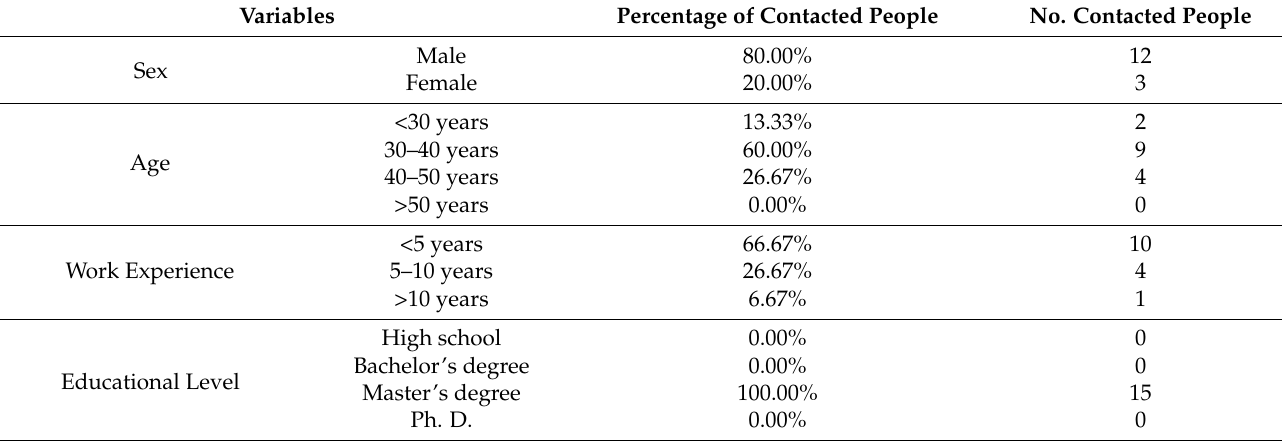
Table 2. Detailed information about the people meeting the criteria in Table 1 and contacted for the survey.